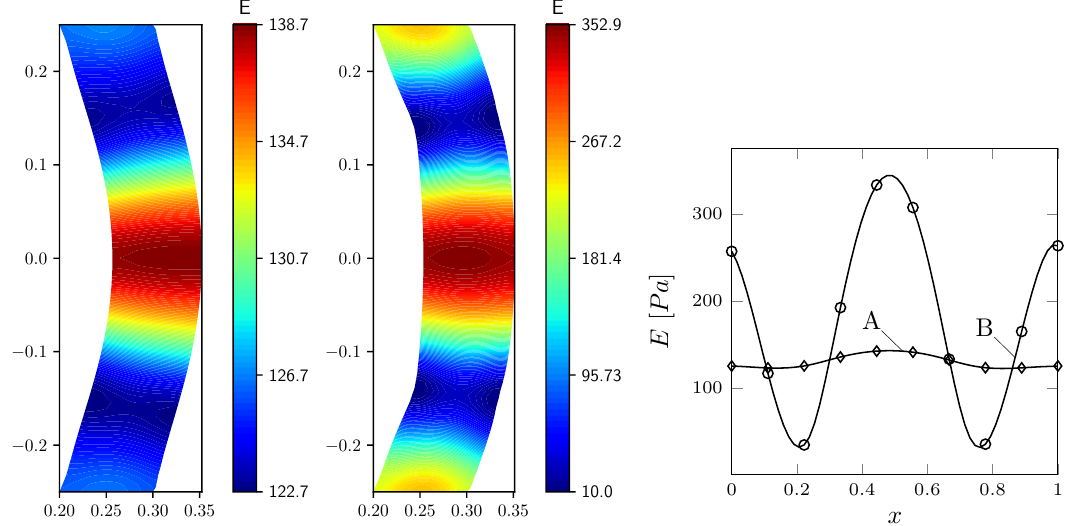
Figure 8. Young modulus E fields, discretization l = 5 with E min = 10 Pa and λ = 10 − 1 ( left ), λ = 10 − 3 ( middle ). Young modulus profile on the solid vertical mid-line ( right ), with E min = 10 Pa and λ = 10 − 1 (A), λ = 10 − 3 (B). E and E min are scaled by 2.4 Table 4. Objective functionals. E min is scaled by 2.4 with